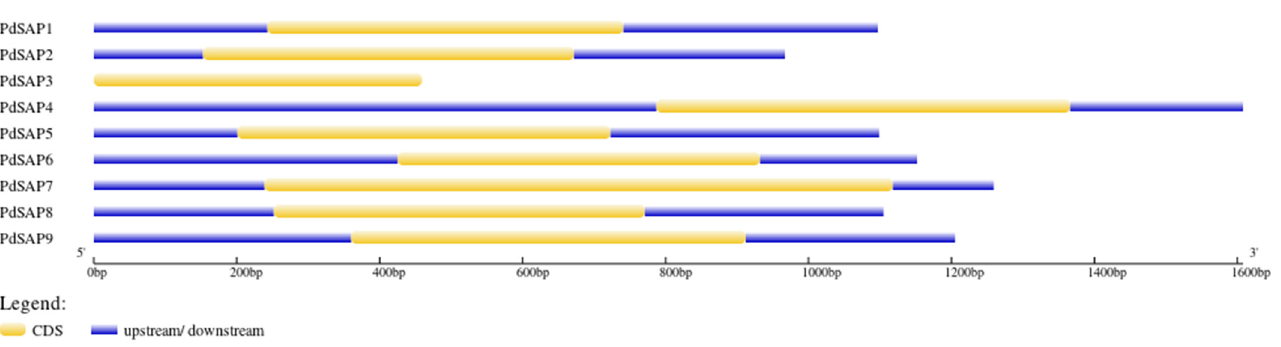
Figure 5. PdSAP motif analysis and gene structure prediction. In the figure, phylogenetic tree ( A ), motif pattern ( B ), and domains ( C ) are visualized.